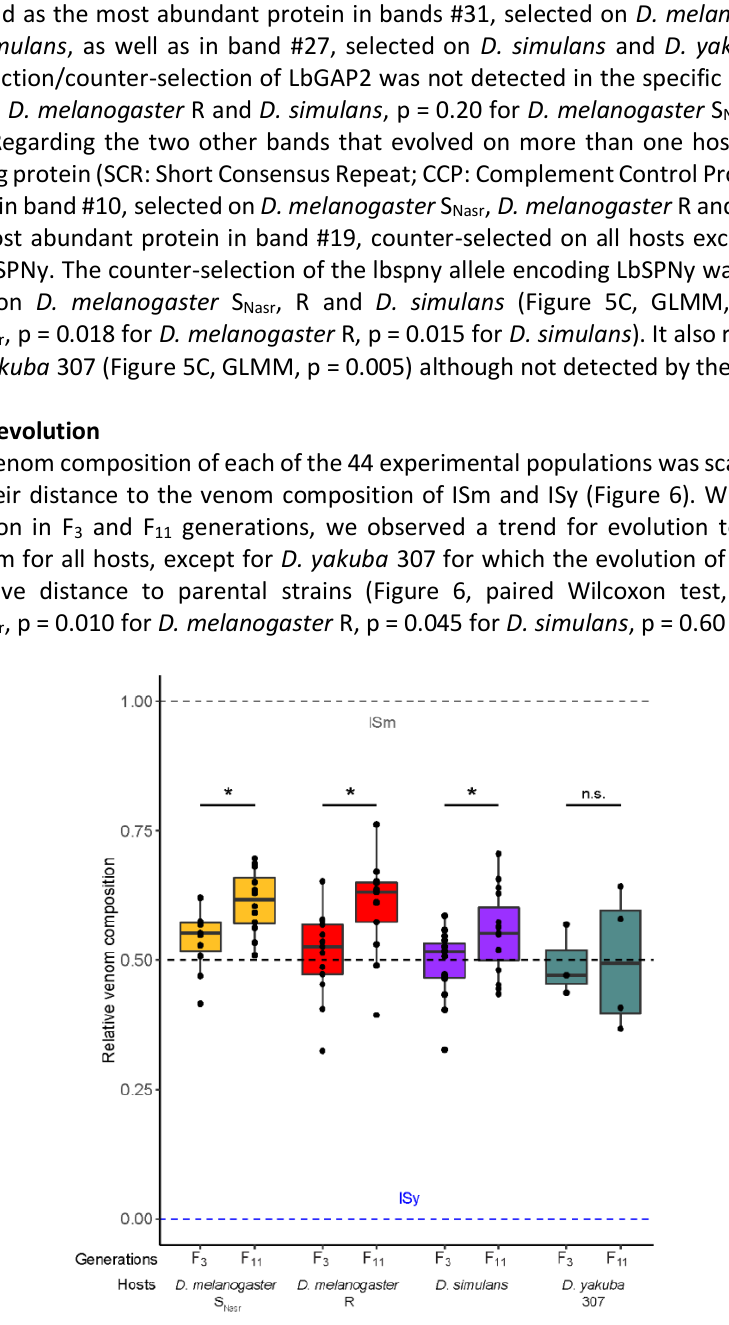
Figure 6. Relative distance between the venom composition of parasitoids selected on D. melanogaster S Nasr (in yellow), D. melanogaster R (in red), D. simulans (in purple) and D. yakuba 307 (in grey-green) in F 3 and F 11 and that of L. boulardi ISm (1) and ISy (0) lines. The horizontal dashed black line indicates the proportion of ISm alleles after the crossing between ISm and ISy lines (0.5 at the